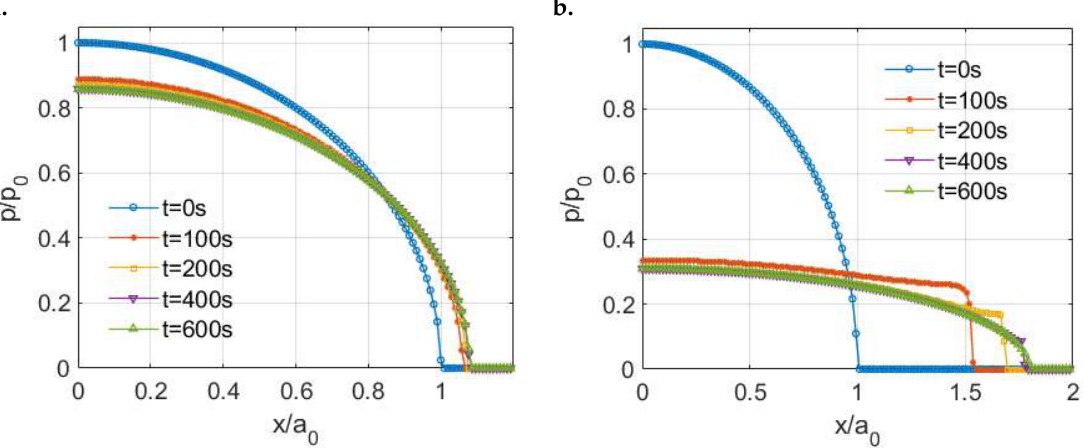
Figure 12. Pressure distributions for different viscoelastic materials (generalized Weichert model) under normal loading: ( a ) PMMA and ( b ) Fictitious viscoelastic material.